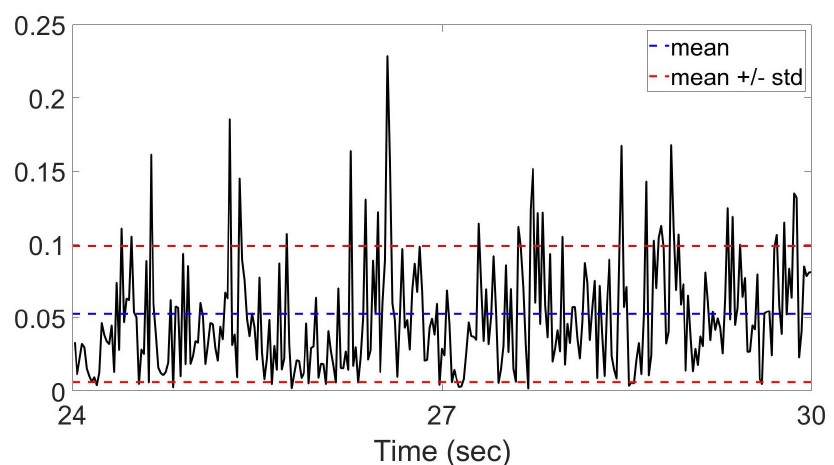
Figure 14. Time series of the dimensionless instantaneous bed shear stress at ( X